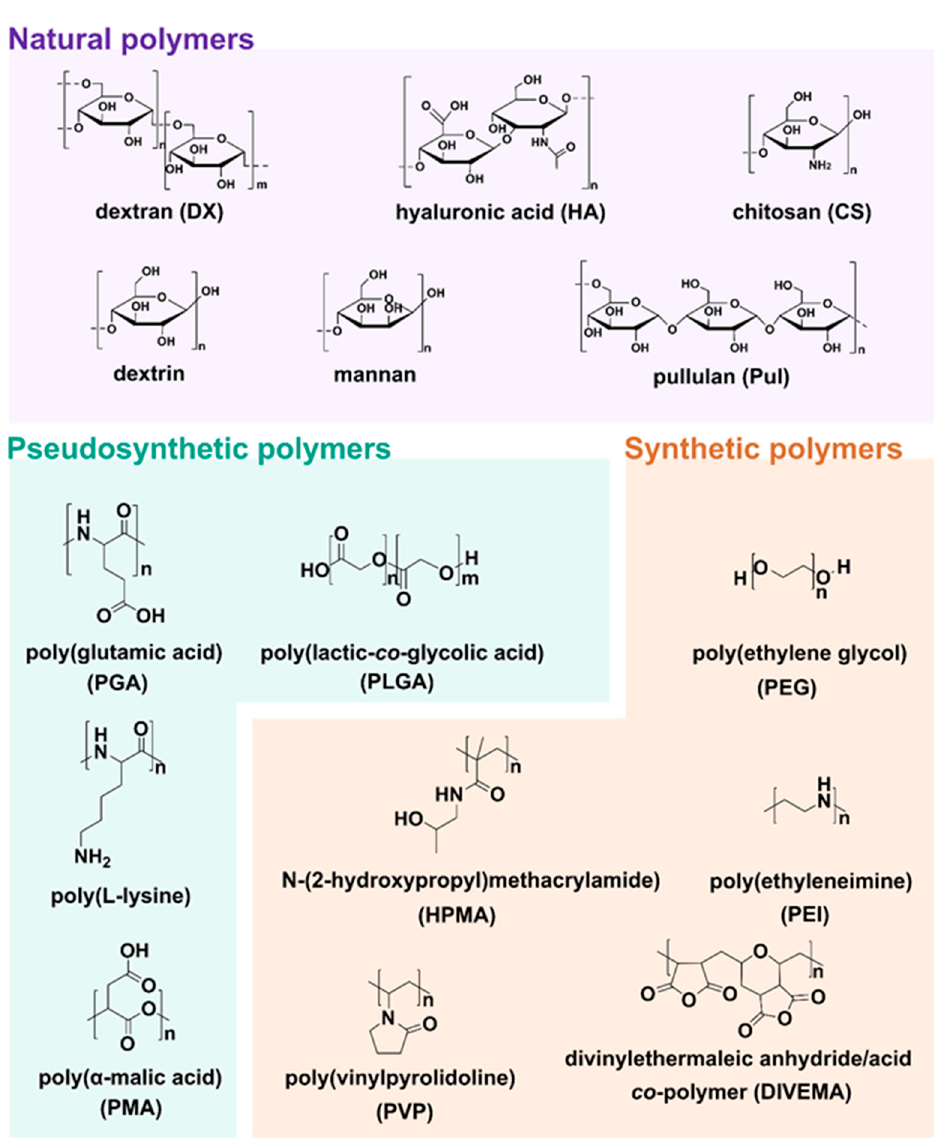
Figure 4. Structures of natural, pseudosynthetic, and synthetic polymers used for drug delivery applications.